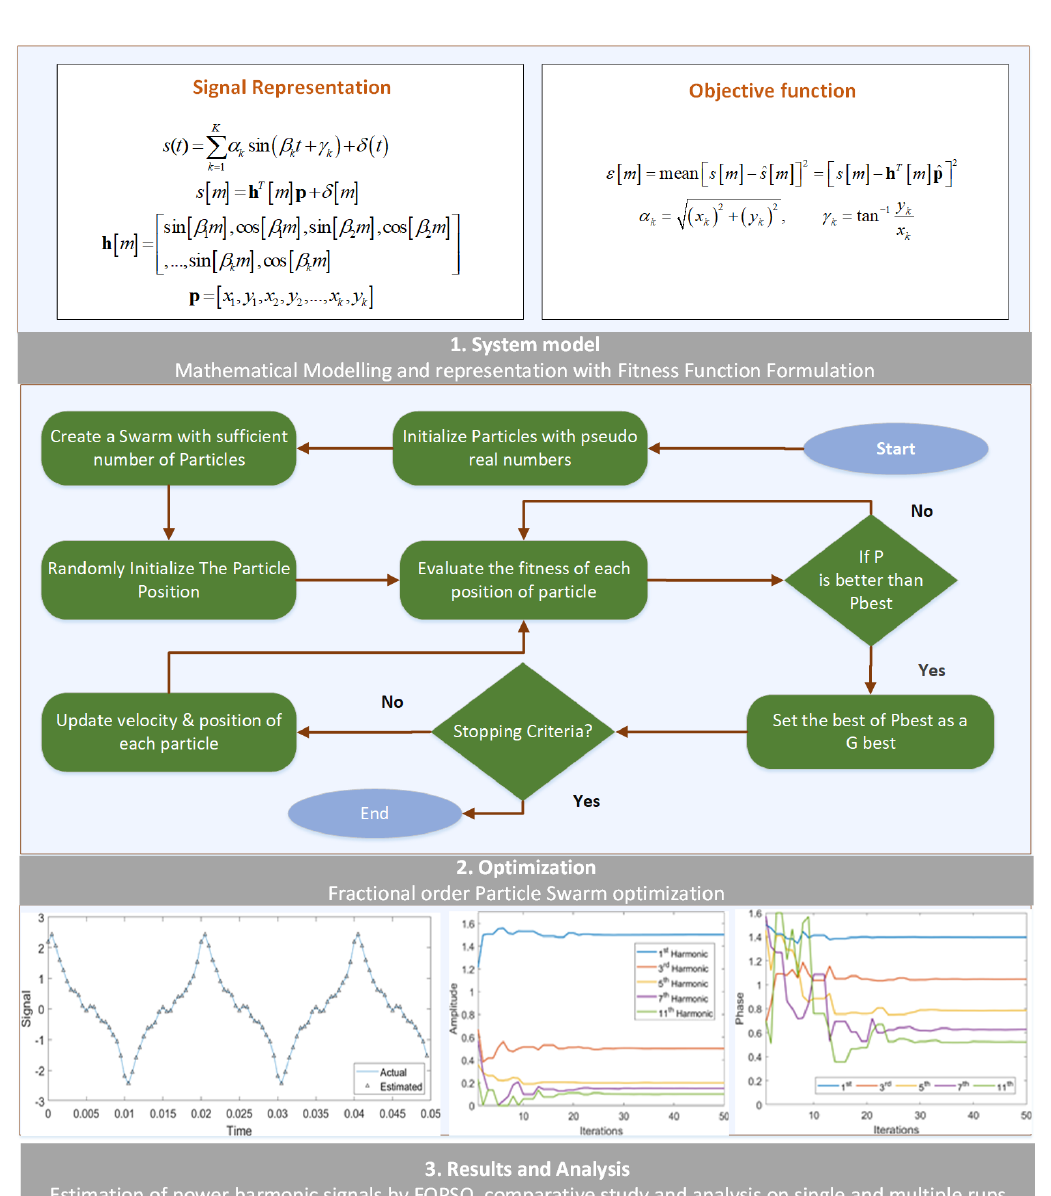
Figure 1. Graphical abstract of the proposed study exploiting FOPSO for solving the harmonic identification model.